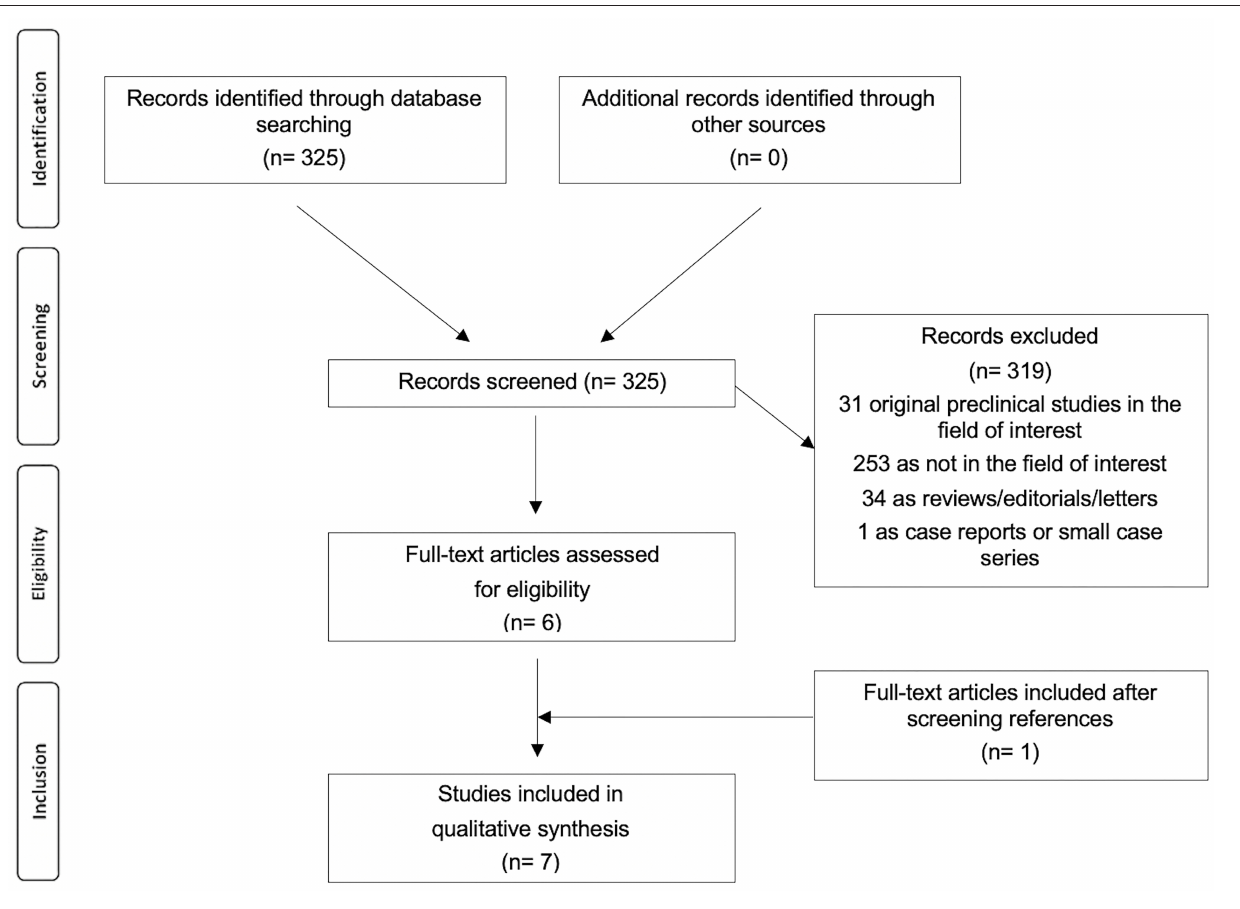
FIGURE 1 | Flowchart of the literature